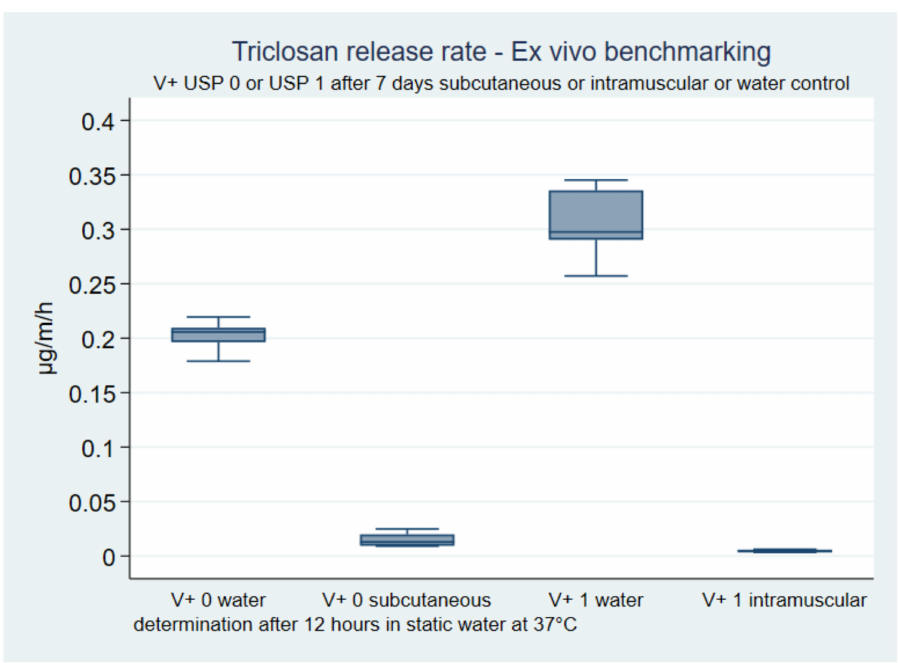
Figure 4. Ex vivo marginal release rate benchmarks versus in vitro controls.